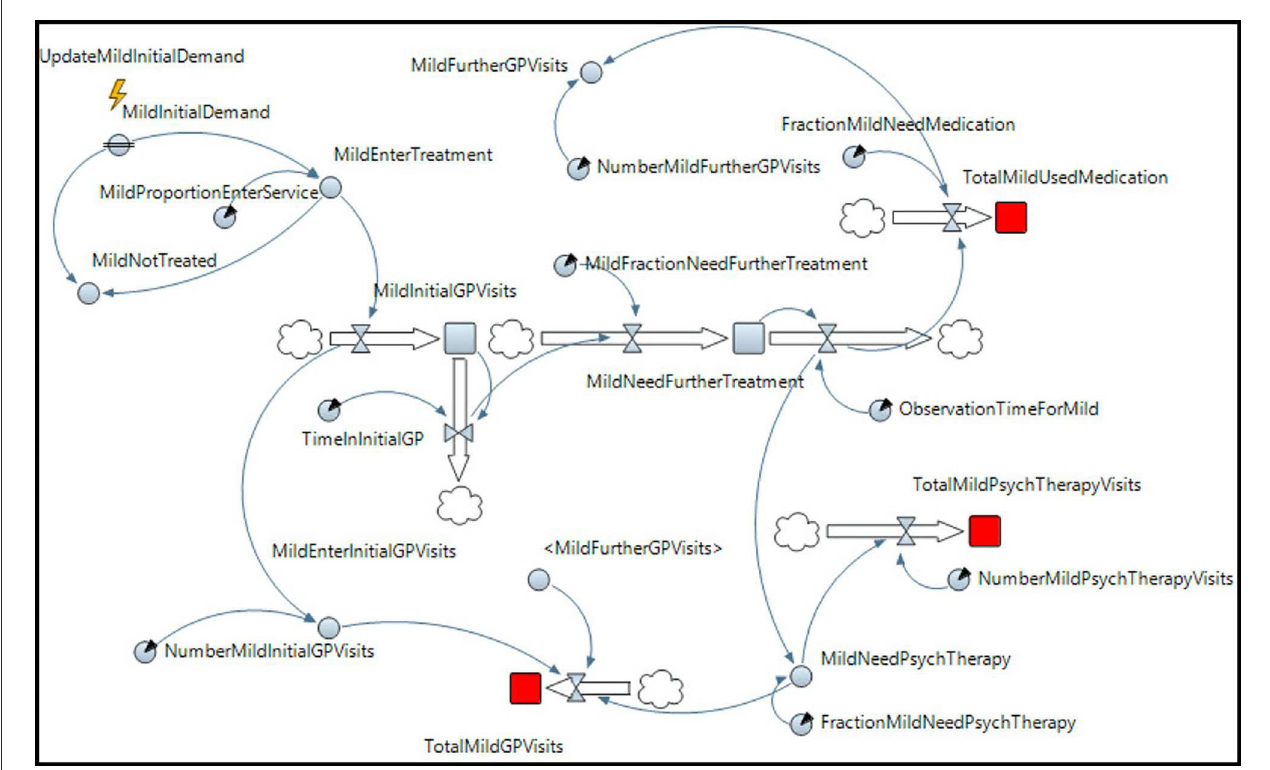
FIGURE1 SD model for mild depression.